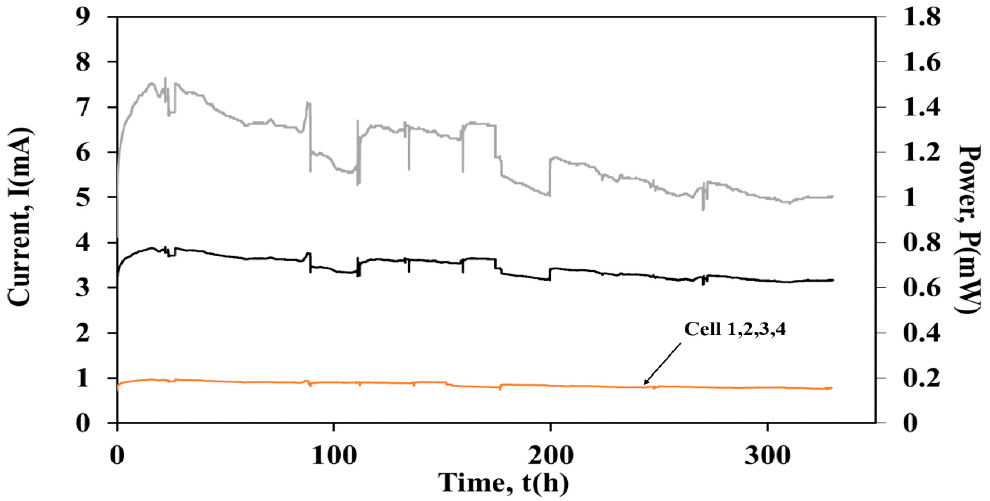
Figure 6. Current output versus time of (a) Cell Stack , (b) Individual cells and power versus time of (c) Cell stack , during parallel connection.